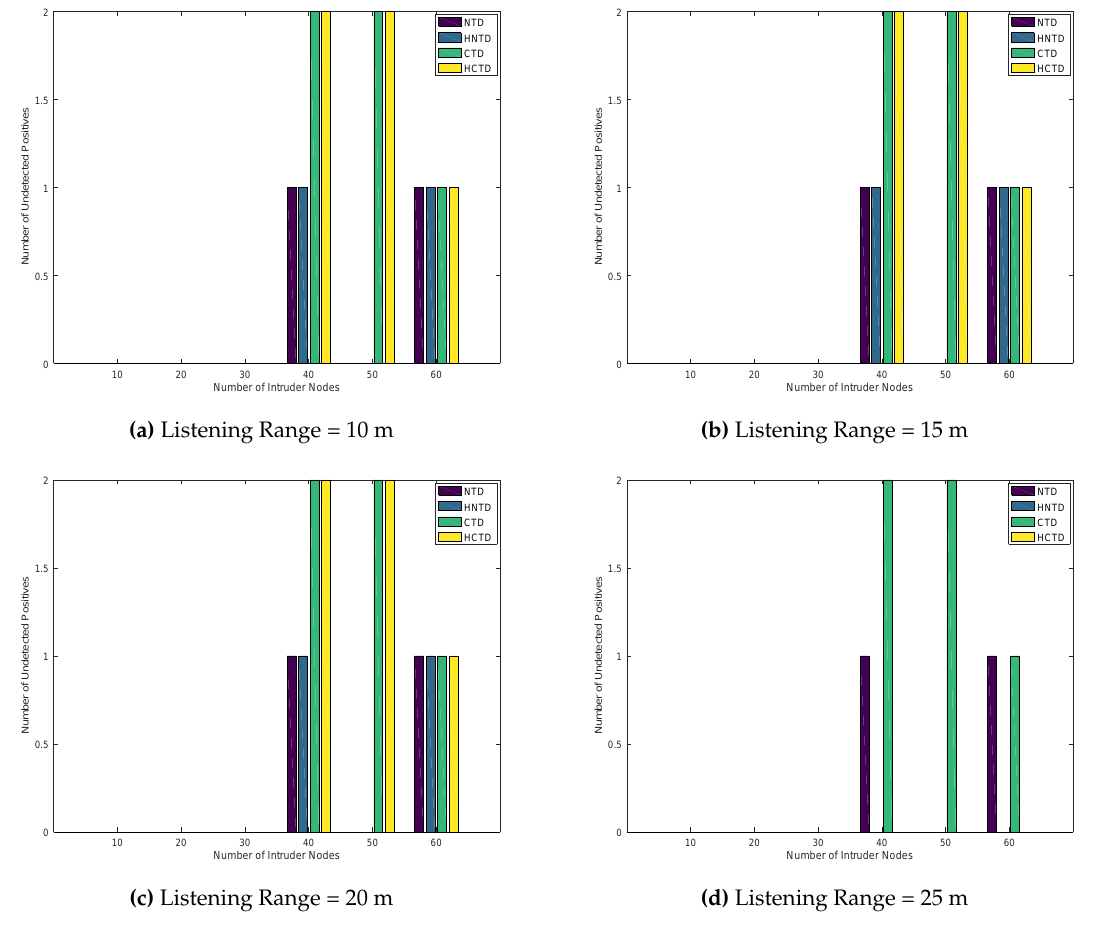
Figure 8. Number of Undetected Positives for Homogeneously placed